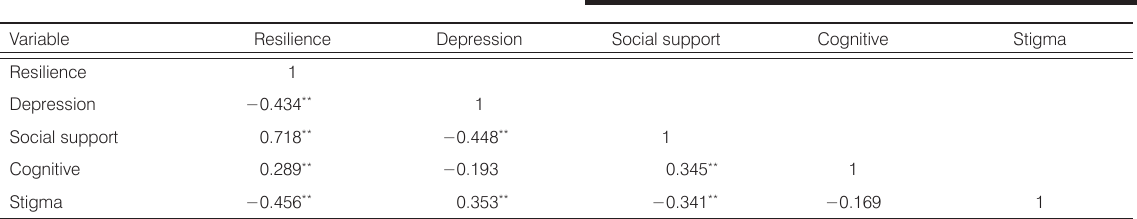
Table 2. Relationships among depression, social support, cognitive, stigma, and resilience by Pearson’s product–moment correlation coefficient. Variable